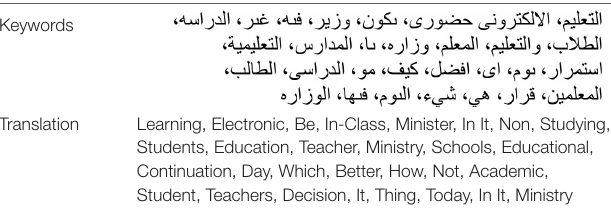
Table 4 | The keywords and their English translation for Figure 4